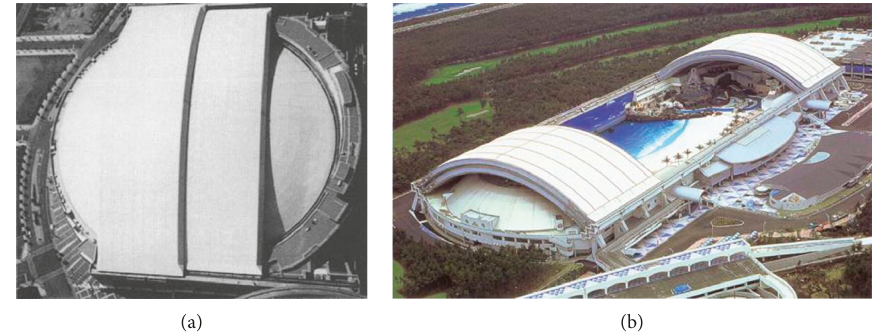
Figure 1: Typical horizontally retractable roof. (a) Sky Dome, Canada. (b) Ocean Dome,